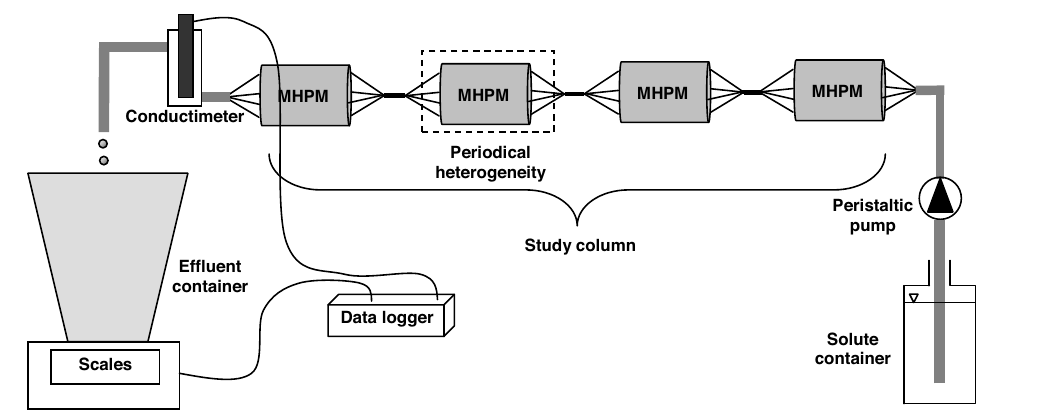
Figure 2. Experimental setup with an example of a series of n = 4 columns.